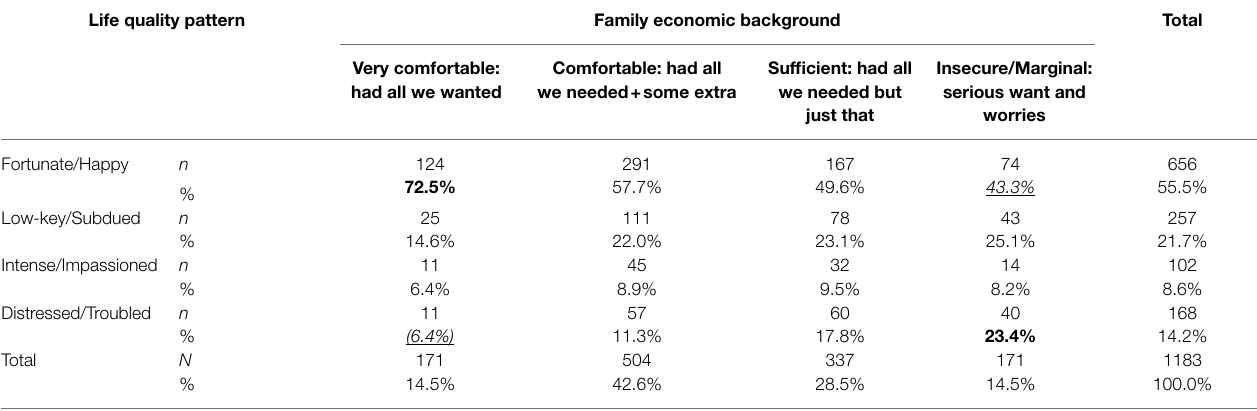
TABLE 8 | Trainees’ current life quality by family economic background. 1,2